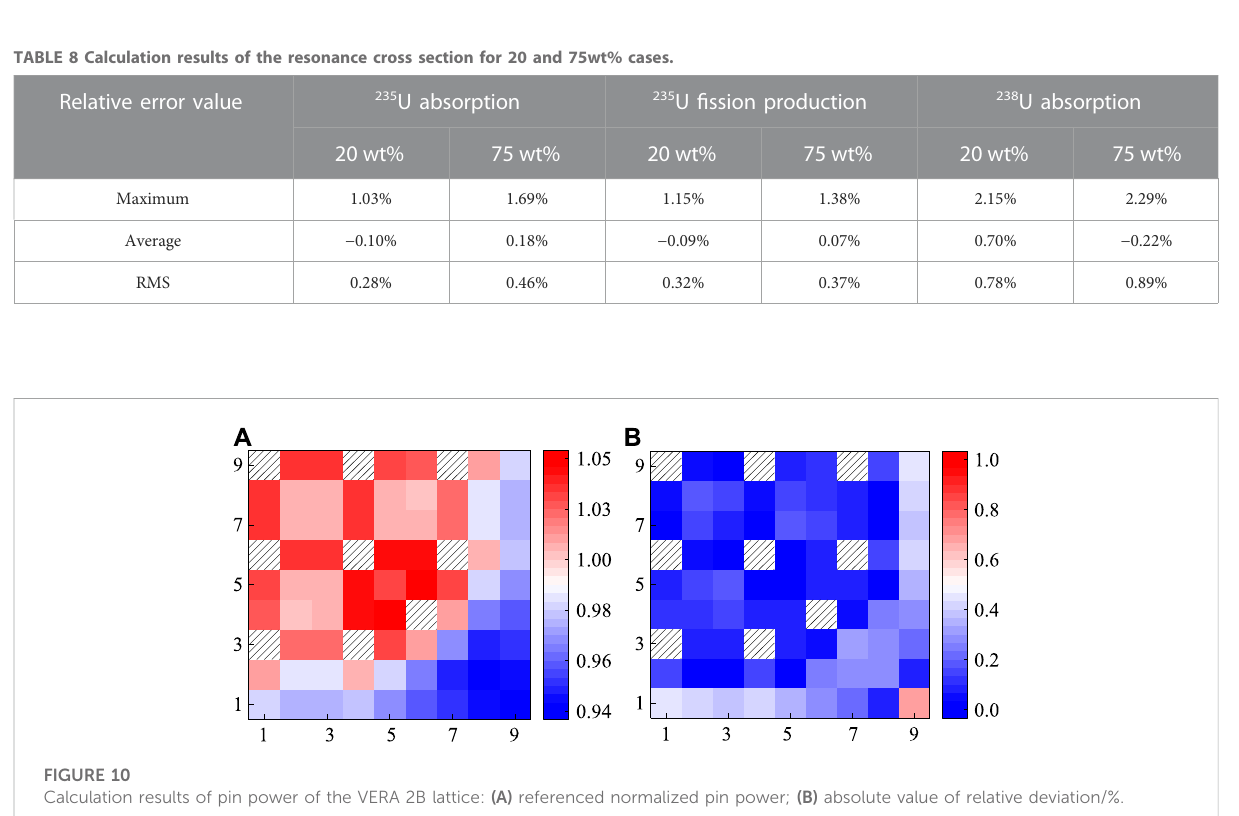
Frontiers in Energy